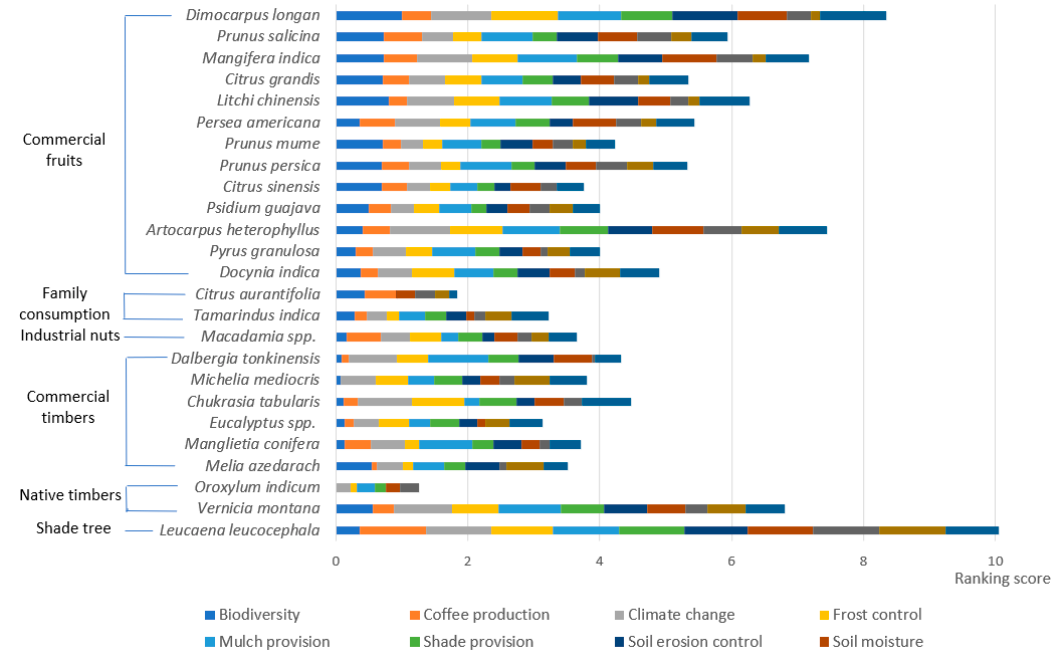
Figure 6. Accumulated tree species ranking scores for various ecosystem services based on the whole group of interviewed male and female farmers in the provinces of Son La and Dien Bien, northwest Vietnam.